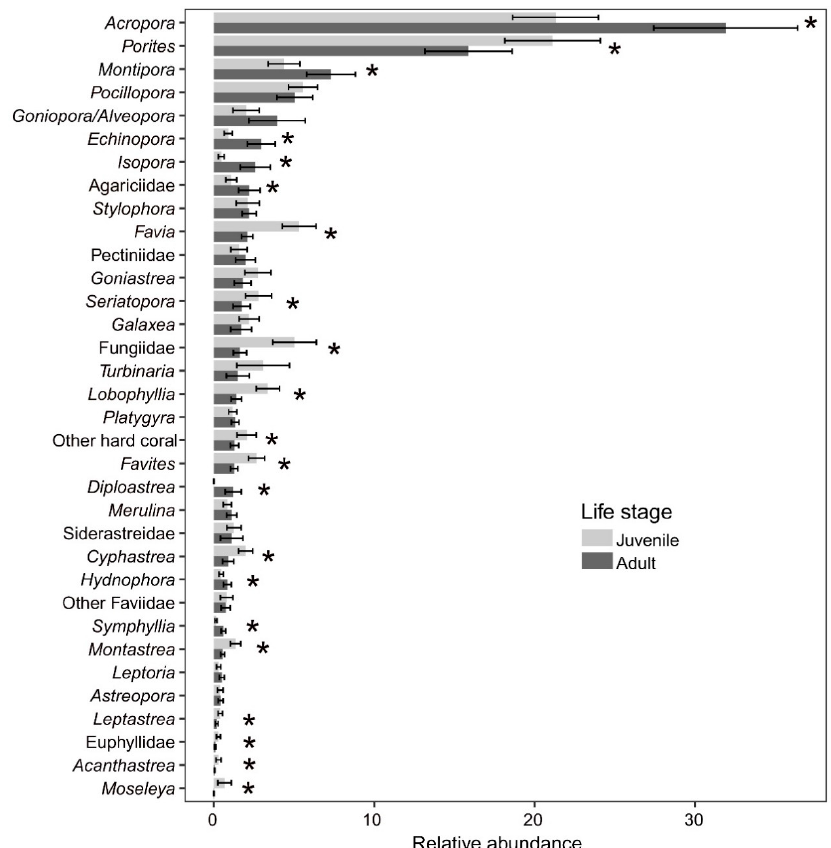
Figure 5. Mean relative abundance of juvenile and adult coral taxa for all reefs in this study. Asterisks indicate significant differences p < 0.05 from Student’s t-tests.